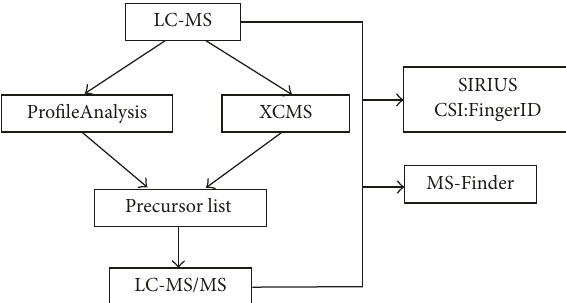
Figure 1: General scheme showing the workflow of data